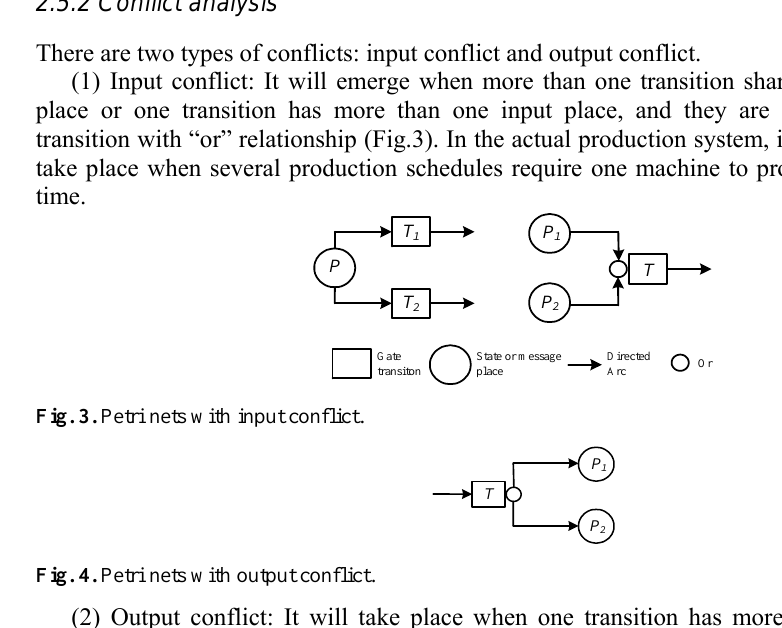
Fig. 3. Petri nets with input conflict.